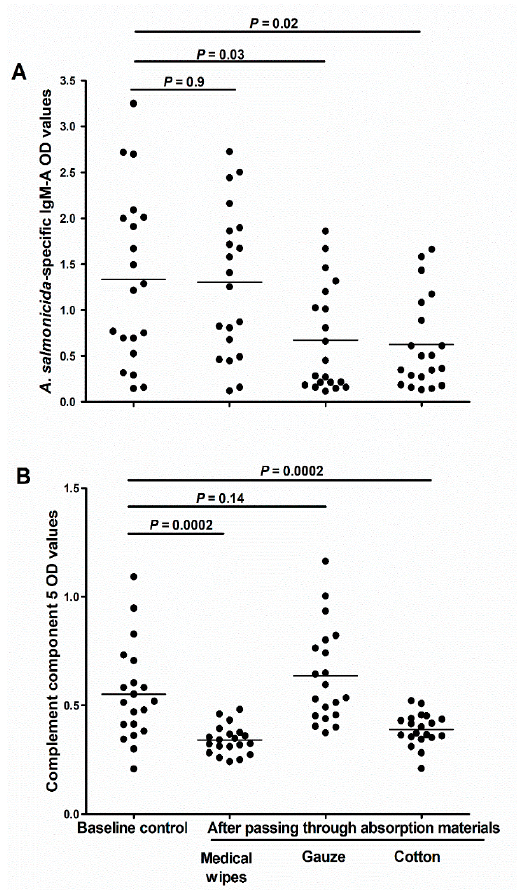
Figure 7. Effect of different mucus absorbing materials on the downstream analyses of the skin mucus samples. ( A ) Scatter dot plot of A. salmonicida specific IgM-A OD values (measured using ECAS-CIA), and ( B ) complement component 5 (measured using ELISA) in scraped skin mucus samples (D2; n = 20) before and after passing the samples through either medical wipes, gauze, or cotton. Horizontal lines represent the median OD values in the di ff erent groups of samples. The nonparametric multiple comparison tests (Wilcoxon each pair) was used to calculate the p